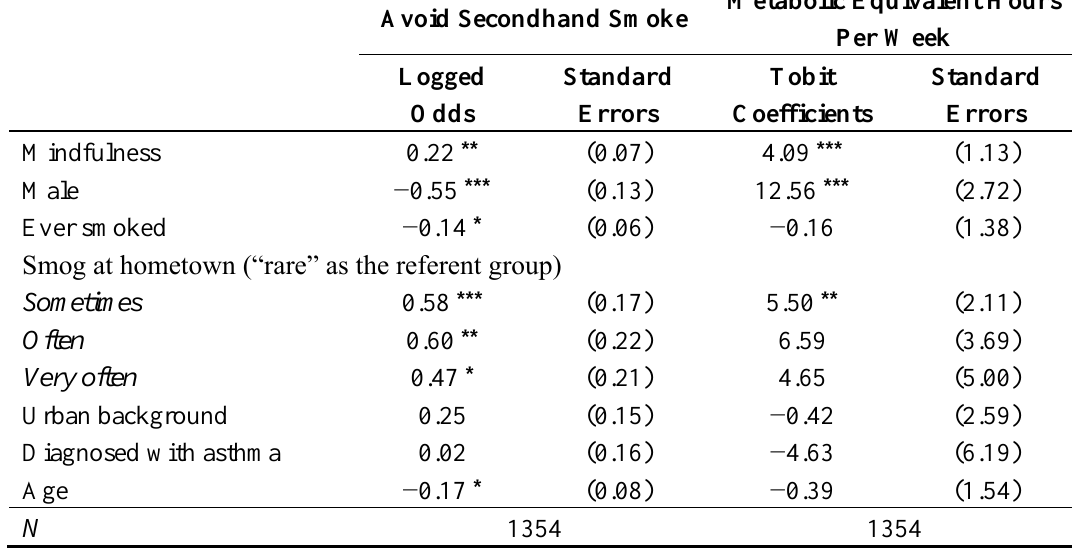
Table 2. Logistic regression of consciously avoiding secondhand smoke and Tobit regression of physical